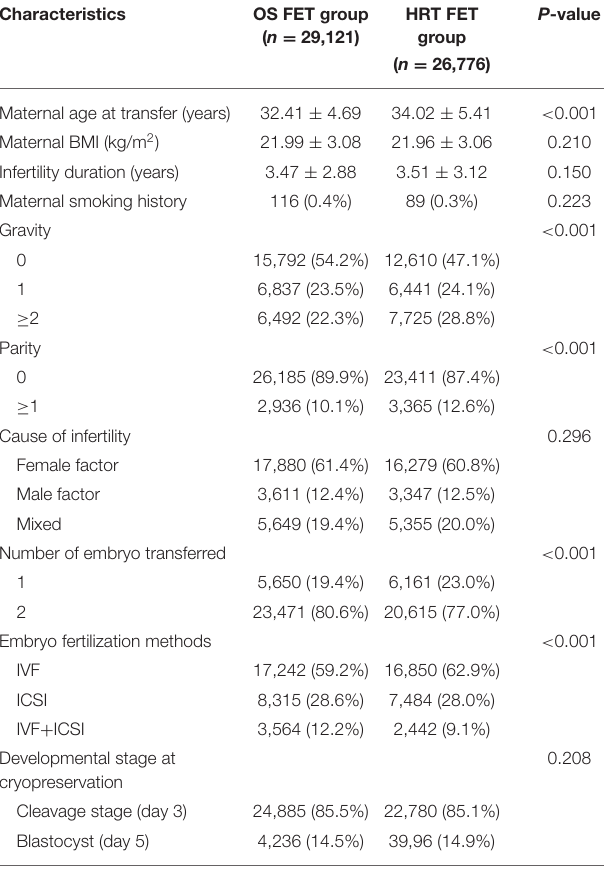
TABLE 1 | Baseline characteristics of OS FET and HRT FET groups. Characteristics